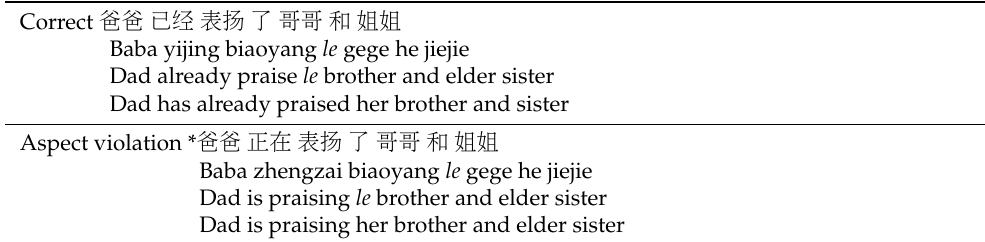
Table 3. Examples of sentences in each